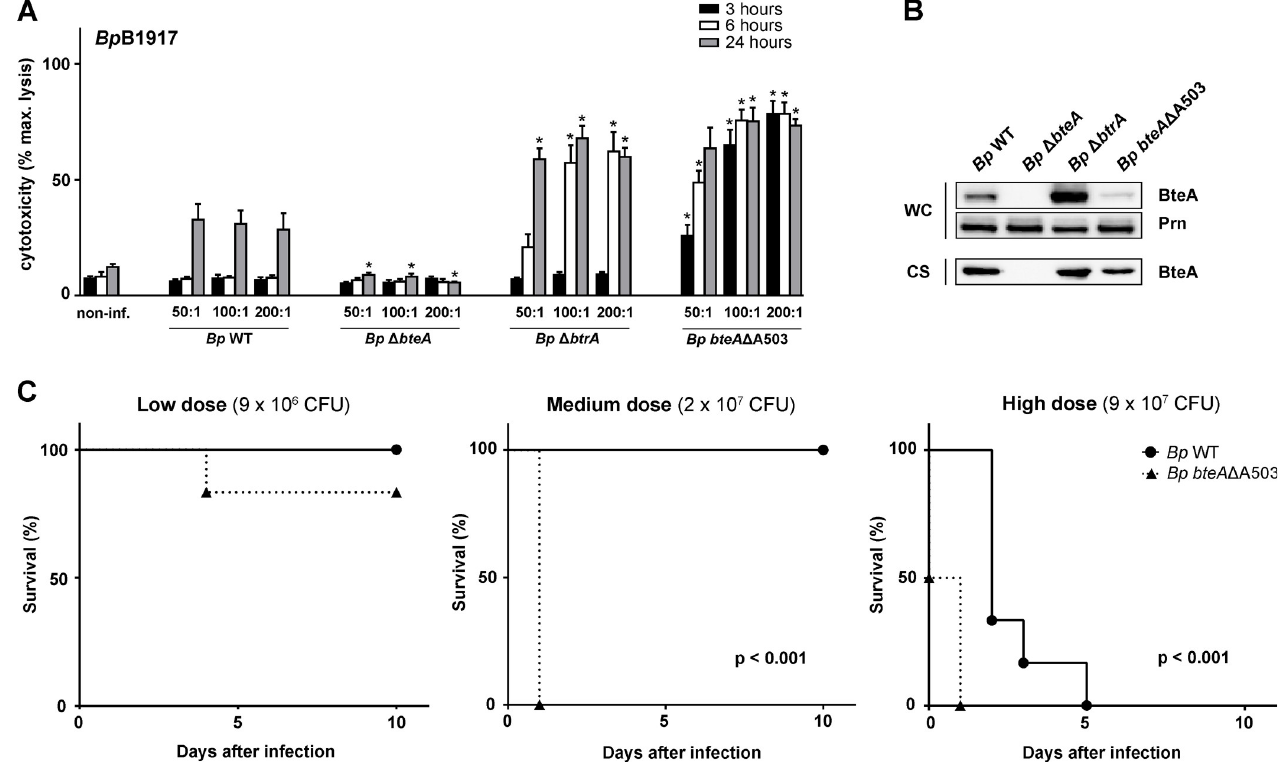
Fig 3. Virulence of B . pertussis is potentiated by the removal of Ala503 residue from Bp BteA effector protein. (A and B) The deletion of Ala-encoding codon 503 in the Bp bteA allele enhances B . pertussis B1917 cytotoxicity. HeLa cells were infected with B . pertussis B1917 wild type ( Bp WT), Δ bteA ( Bp Δ bteA ), Δ btrA ( Bp Δ btrA ), or bteA Δ A503 ( Bp bteA Δ A503) at an MOI of 50:1, 100:1 and 200:1. Cytotoxicity was measured as lactate dehydrogenase (LDH) release 3, 6, and 24 h post-infection. Values represent the means ± SE for 3 independent experiments performed in duplicate ( n = 6). � p < 0.01, compared with Bp WT- infected cells, unpaired two-tailed t -test using the corresponding infection time and MOI. (B) Immunoblot analysis of whole-cell lysates (WC; 0.1 ml of culture equivalent; OD 600 = 1) and culture supernatants (CS; 1 ml of the culture equivalent; OD 600 = 1) of the indicated strains using anti-BteA (BteA, 1: 10,000) or anti-pertactin (Prn, 1:10,000) antibodies. A representative experiment out of 2 is shown. (C) The deletion of Ala503 residue from Bp BteA effector protein enhances B . pertussis B1917 virulence. Five-week-old female Balb/cByJ mice were intranasally infected with indicated doses of B . pertussis B1917 wild type ( Bp WT) or bteA Δ A503 ( Bp bteA Δ A503) derivative. Survival rates were monitored over a 10-day period. The results are representative of 3 independent experiments using 6 mice per challenged group and challenge dose. p -values represent significant differences in survival distributions between Bp WT vs. Bp bteA Δ A503, long-rank test using the corresponding infection